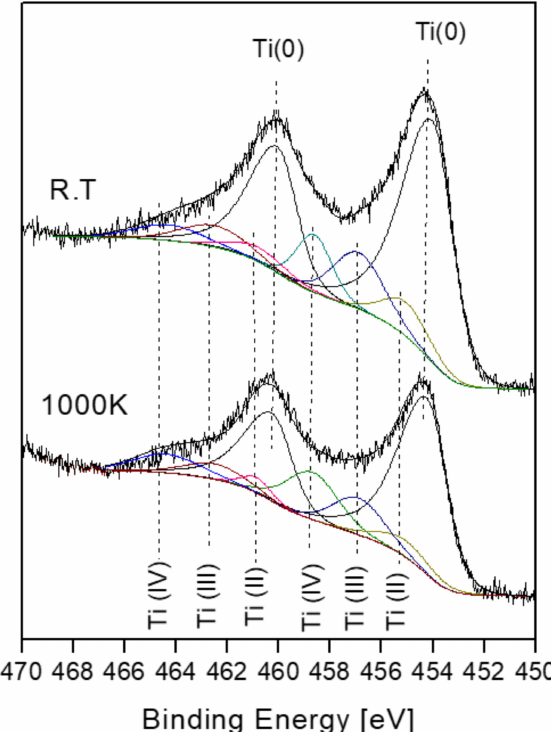
Figure 11. XPS spectra of Ti after exposing to 5000 L H 2 O at RT and 1000